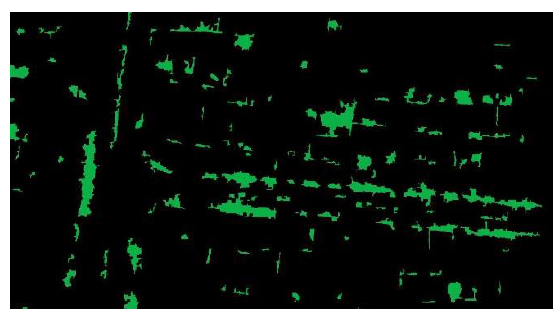
Figure 1. Original images of Esfahan City